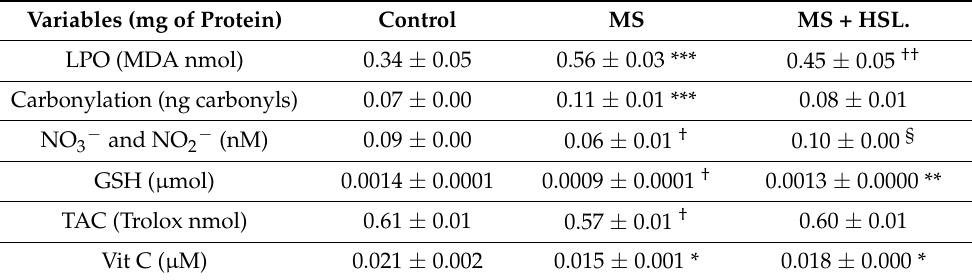
Table 3. Oxidative stress indicators in the kidney homogenate in the experimental